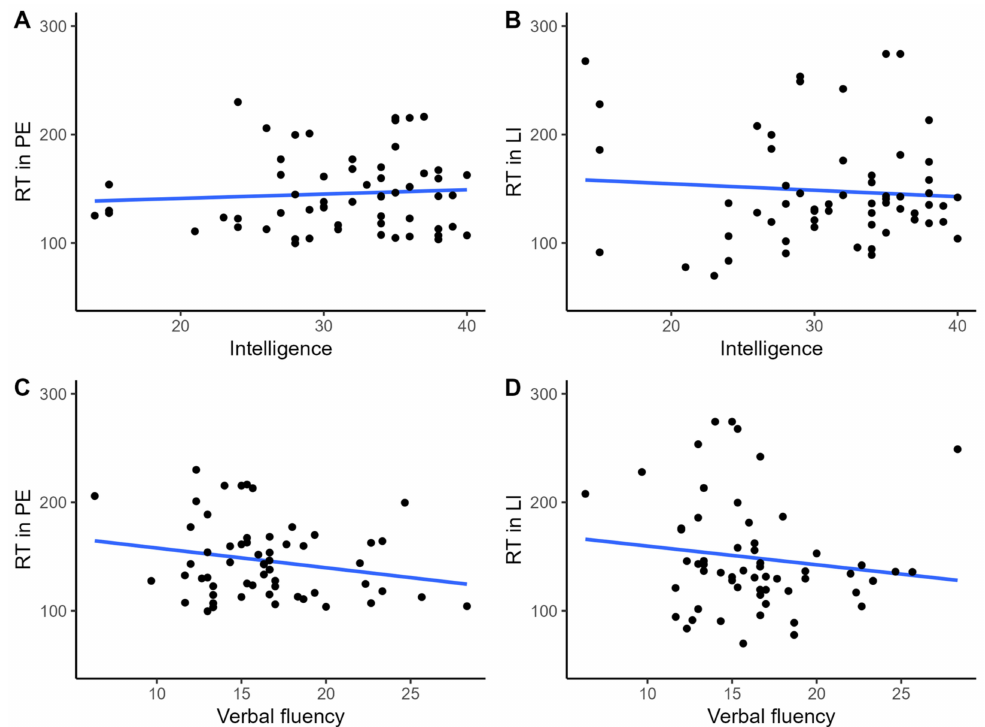
Figure 3. A scatter plot with a line of best fit to illustrate the relationship between intelligence score in Choynowski’s test and verbal fluency test with reaction times in the PE ( A , C ) and LI ( B , D ) conditions measured in apparently healthy individuals.